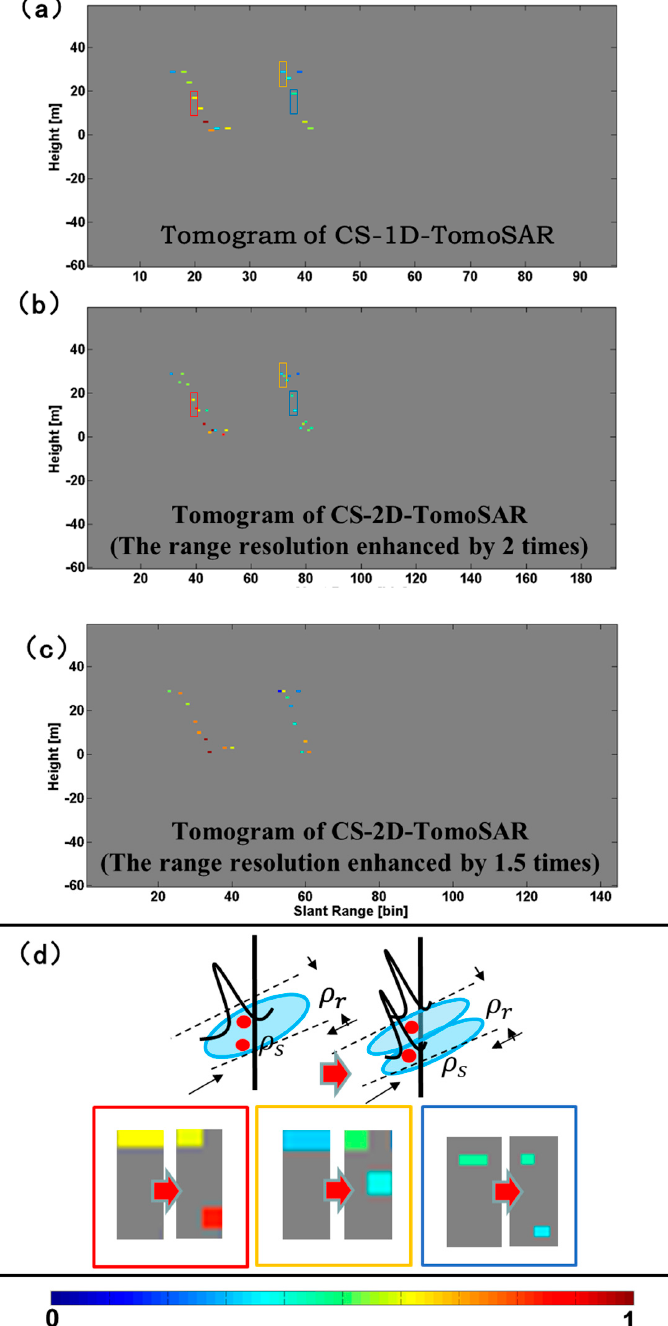
Figure 11. Elevation-range sections of tomographic reconstruction over the test line, obtained with ( a ) CS 1D TomoSAR method; ( b ) CS-2D-TomoSAR with the range resolution enhanced two-fold; and ( c ) CS-2D-TomoSAR with the range resolution enhanced 1.5-fold; ( d ) The comparison of the detailed reconstruction results between the CS 1D TomoSAR and CS 2D TomoSAR methods. The color is associated to the estimated scattering magnitude of objects.